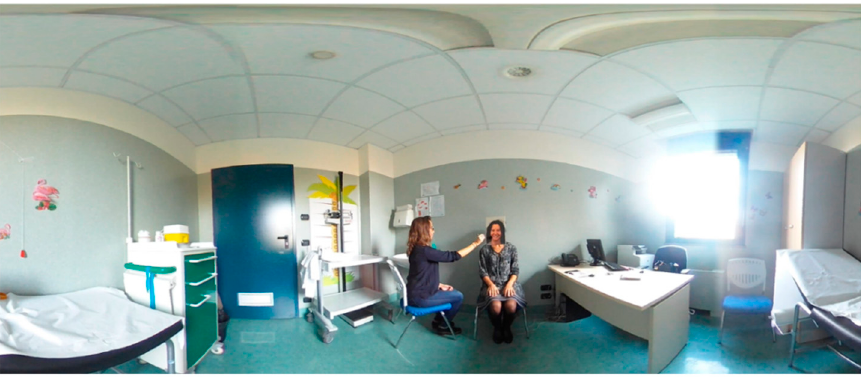
Figure 4. Caption of the 360 ◦ video while applying the face visuo–tactile stimulation to induce the enfacement illusion.